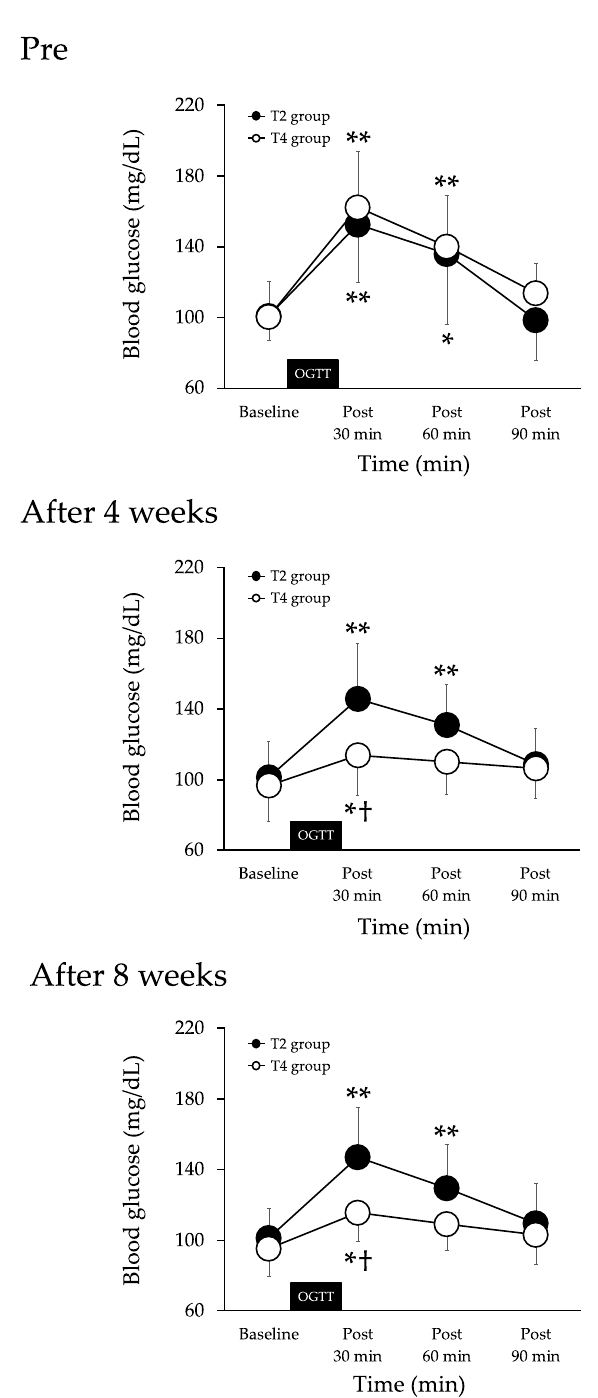
Figure 3. Changes in blood glucose before (baseline) and after the 75 - g - OGTT in both groups. Values are mean ± SD. T2 group, aerobic exercise training twice a week. T4 group, aerobic exercise training 4 times a week. OGTT, 75-g oral glucose tolerance test. ** p < 0.01 and * p < 0.05 vs. baseline. † p < 0.05 vs. T2 group.